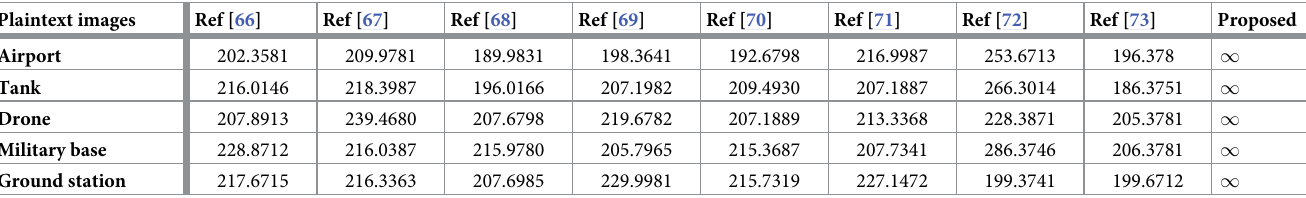
Table 12. PSNR for loseless